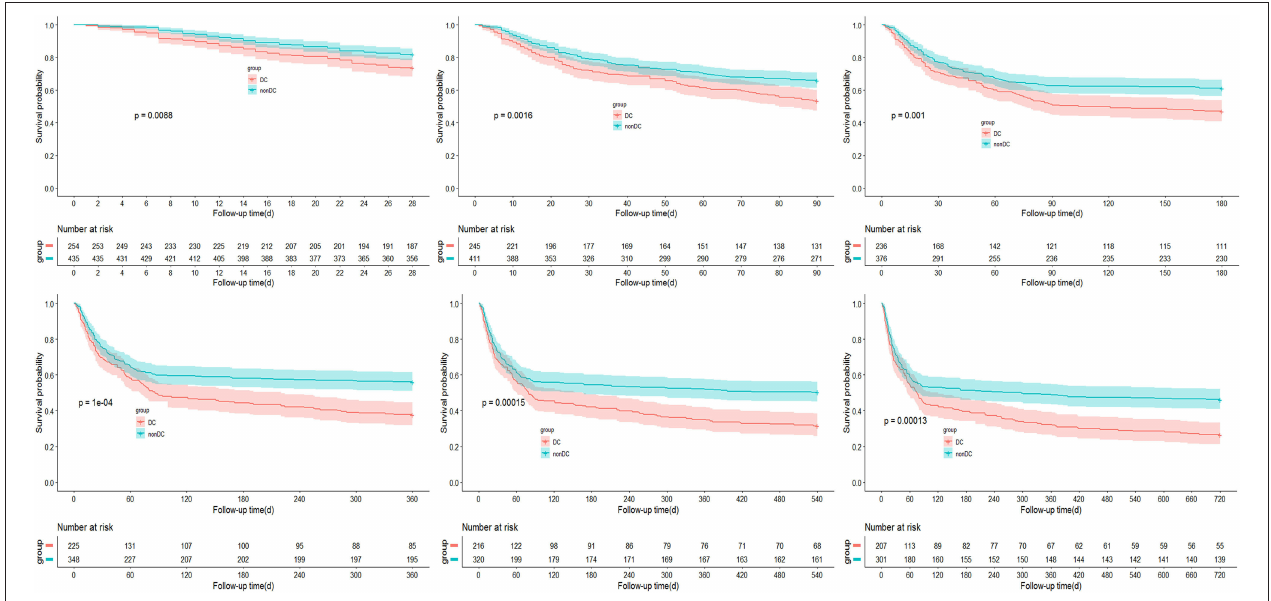
FIGURE 2 | Incidence of transplant-free survival in ACLF patients with and without decompensated cirrhosis